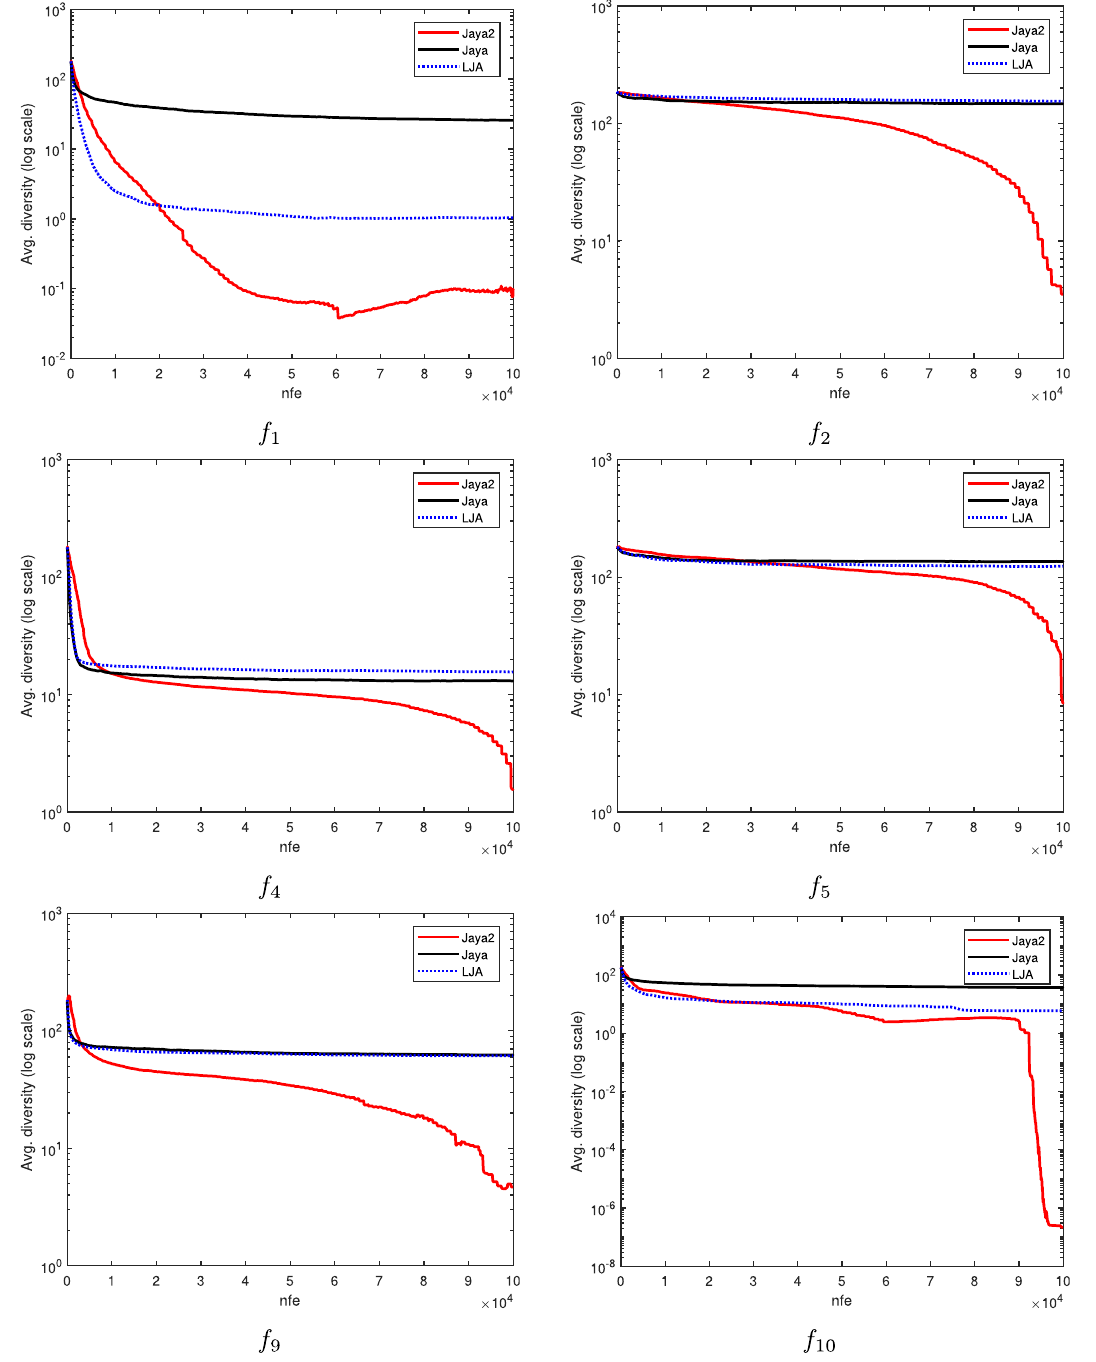
Figure 5: Diversity curves ( averaged across 30 runs ) of Jaya2, Jaya, and LJA for selected CEC 2020 benchmark functions ( = D 10 )